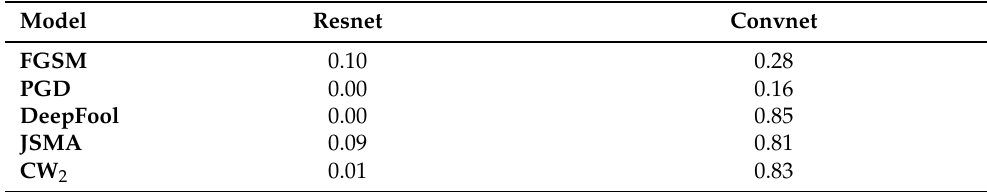
Figure 5. The IACS value with different attacks. Green denotes normal examples’ box plots, and black denotes adversarial examples’ box plots. Table 4. The accuracy of different adversarial examples in Resnet (target model) and